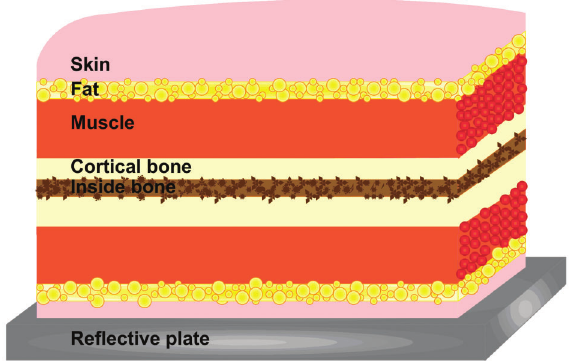
Figure 3. Layers of biological tissues (skin, fat, muscle, cortical bone, inside bone) and reflective